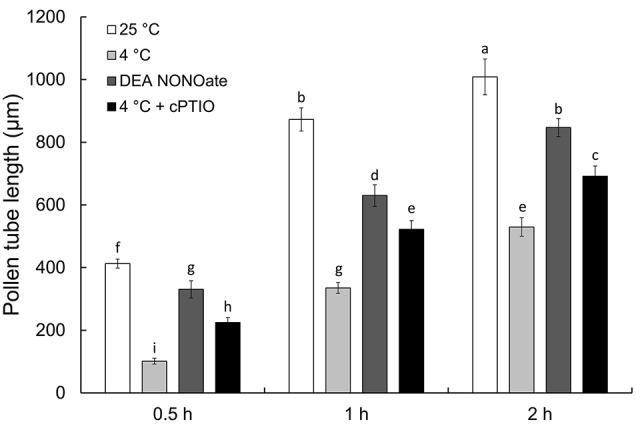
Effects of cold stress or DEA NONOate on the growth of C. sinensis pollen tube. The growth of pollen tubes was significantly delayed after treatment with cold stress (4°C) or 25 μM DEA NONOate, and the effects of cold stress were reduced by 200 μM cPTIO. The values are the means of three replicates ± SD (n ≥ 50). Different letters on bars denote significant differences at P < 0.05 according to Duncan's test.